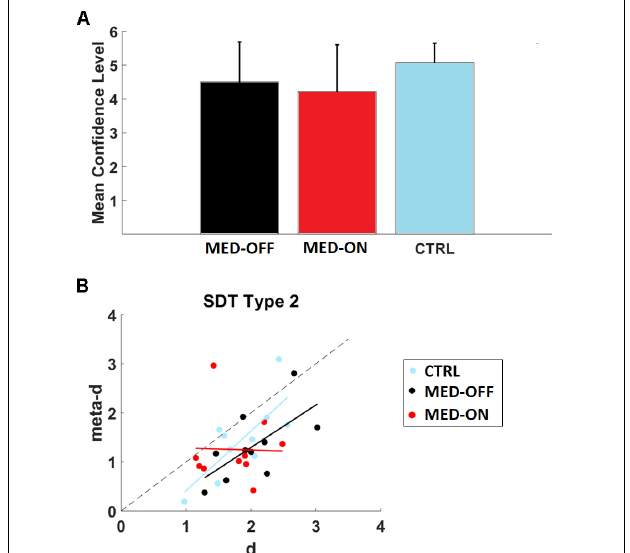
FIGURE 3 | (A) Mean confidence level for conditions (MED-OFF, MED-ON, and CTRL); (B) Assessment of relative type 2 sensitivity: meta-d (observed type 2 sensitivity) and d (type 1 sensitivity) for each subject across conditions (MED-ON, MED-OFF, CTRL). Computation of such parameters was performed by using the code provided by Maniscalco and Lau (2012). Note that if meta-d = d, then a subject is metacognitively “ideal,” while the degree to which meta-d is smaller than d reflects the degree to which the subject is metacognitively inefficient. Linear regression models with dependent and independent variables (meta-d and d) for conditions: MED-ON [meta-d = − 0.0401 ∗ d+1.3215, r 2 =0.00068, p = 0.943 (slope)],